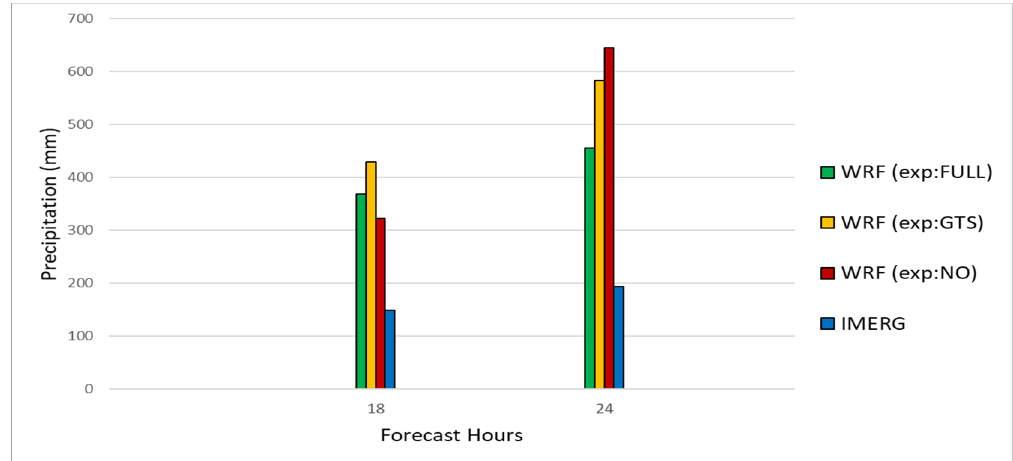
Figure 19. Bar chart depicting the spatial maximum values of the accumulated precipitation in mm from 18 to 24 UTC on 18 September 2020 for the high-resolution domain. Green corresponds to the FULL experiment forecasts, yellow to the GTS experiment, red to the NO experiment, and blue to the IMERG precipitation product.